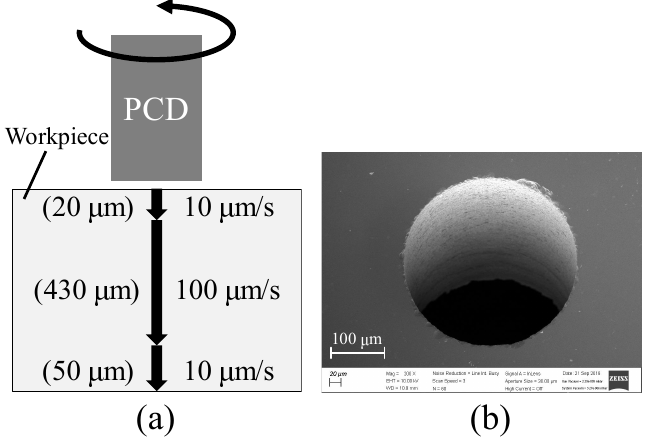
Figure 11. ( a ) Schematic diagram of microdrilling using variable feedrates and ( b ) SEM image of drilled hole (drilling condition: rotational speed of 50,000 rpm).